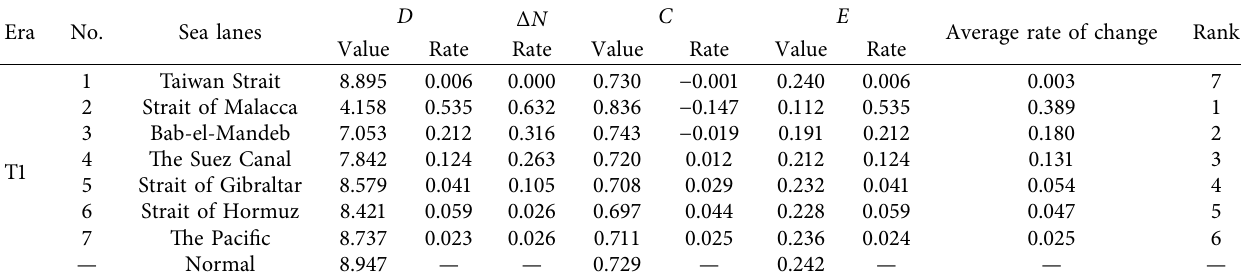
Table 8: Changes in the eigenvalues when sea lanes are